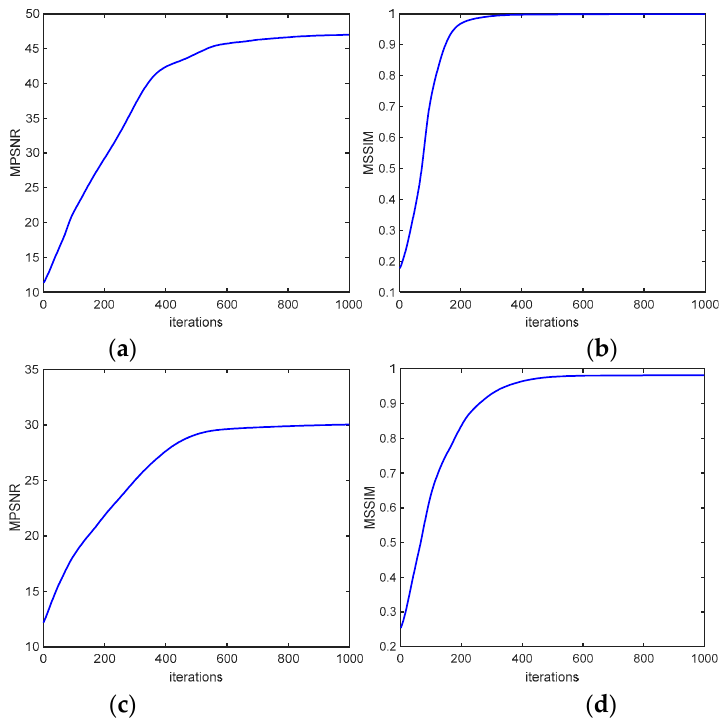
Figure 14. MPSNR and MSSIM value versus the iteration number of GLTSA. ( a ) Change in the MPSNR value (periodic). ( b ) Change in the MSSIM value (periodic). ( c ) Change in the MPSNR value(non-periodic). ( d ) Change in the MSSIM value (non-periodic).